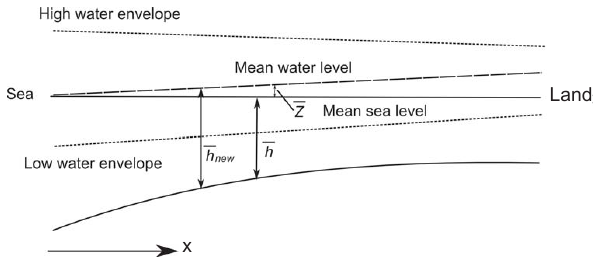
Figure 2. Sketch of the water levels in an estuary, where z is the residual water